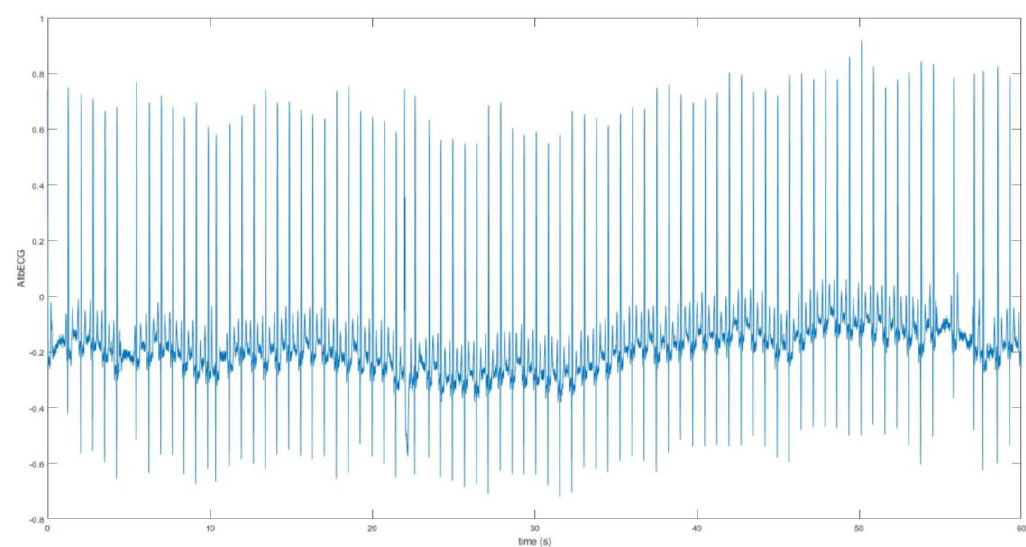
Figure 8. Atrial fibrillation (AF) ECG signal for 60 s (data obtained from the MIT-BIH database).